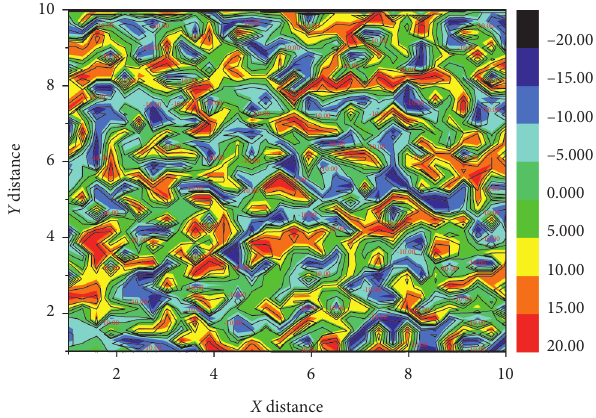
Figure 8: Reconstructed image of single element